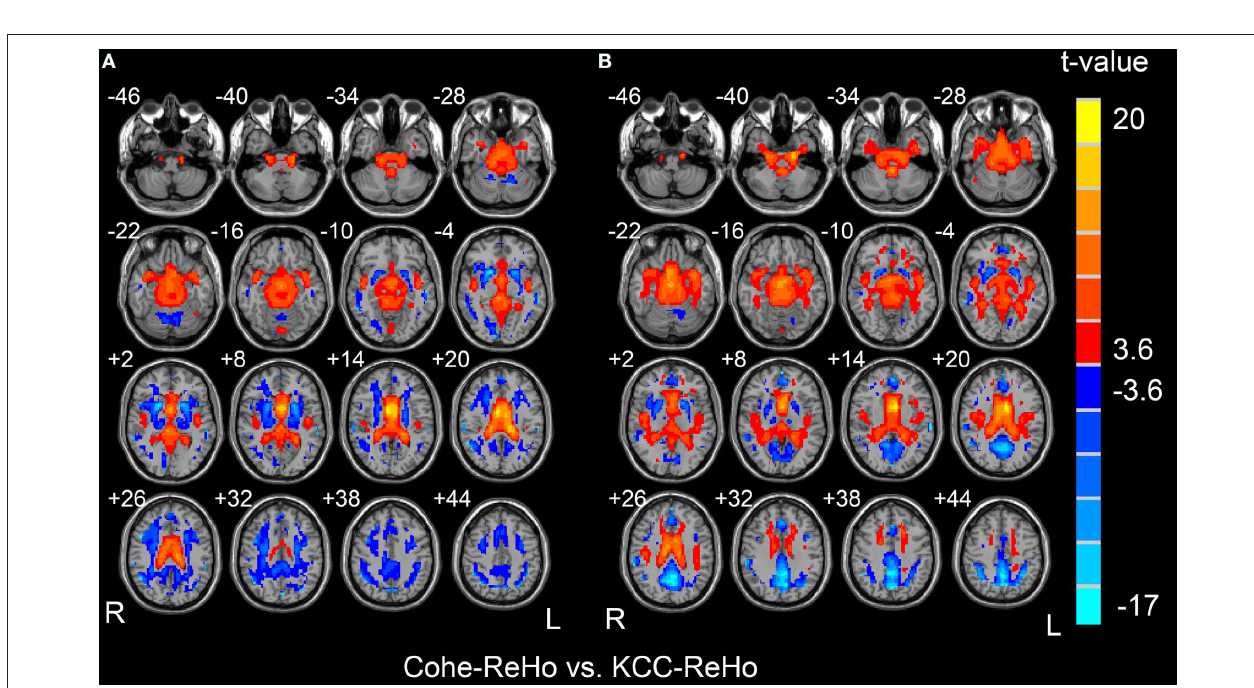
FIguRe 3 | Results of paired t -tests between Z maps of Cohe-ReHo and KCC-ReHo for Dataset-1 (A) and Dataset-2 (B). The left side of the image corresponds to the right side of brain.